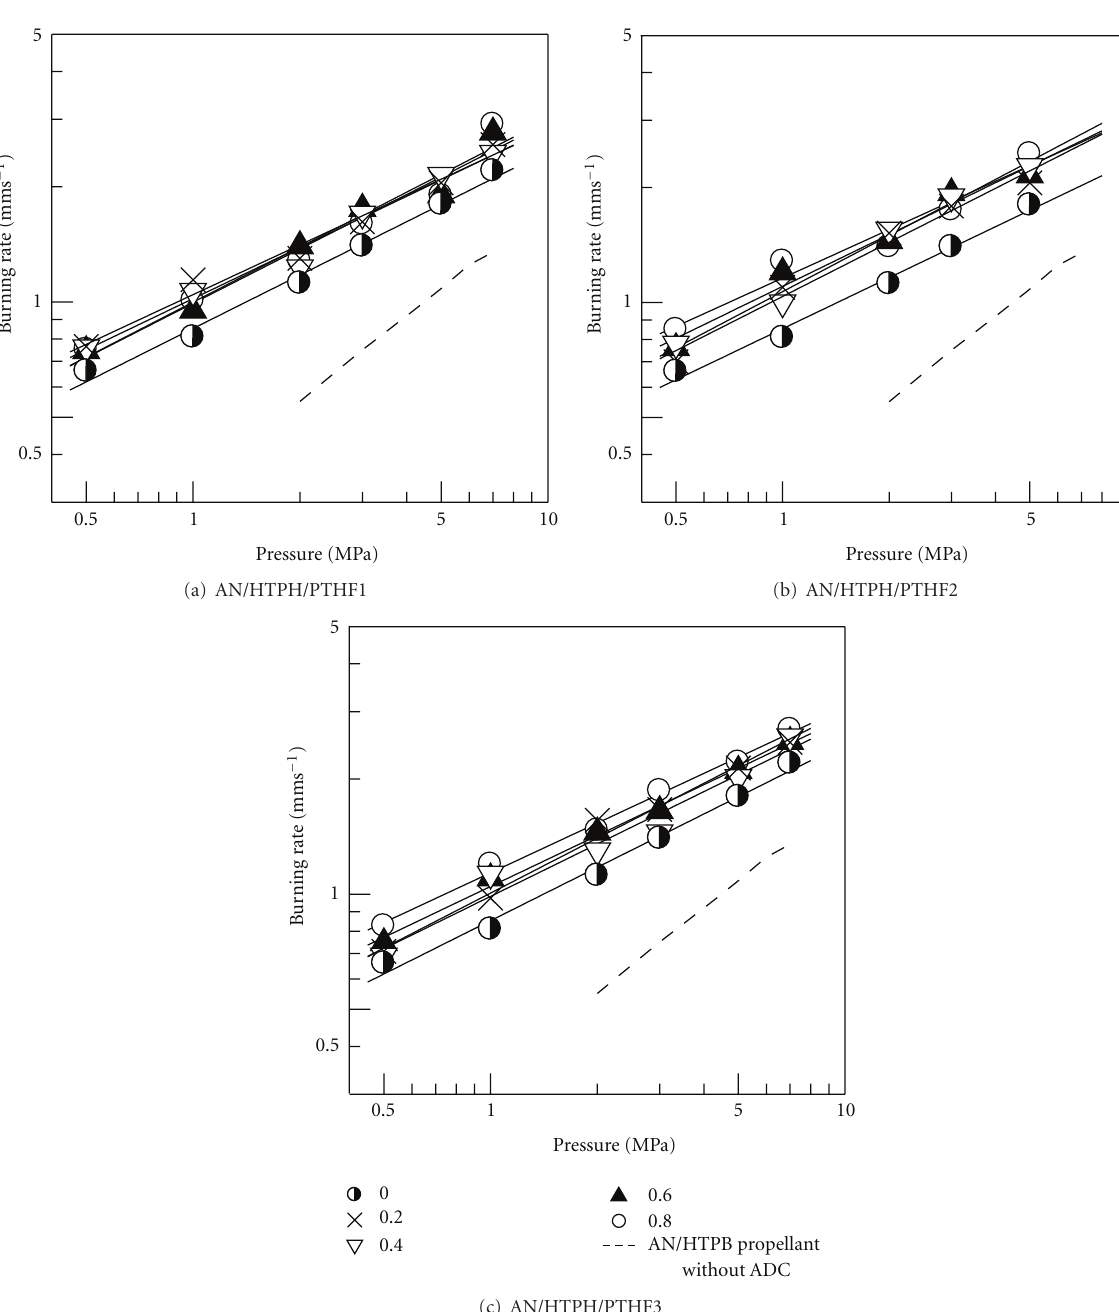
Figure 4 with broken lines for comparison. The